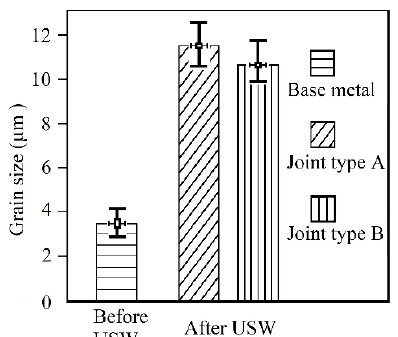
Figure 10. Comparison of base metal mean grain size before and after HP-USW for joint type A (1400 J) and joint type B (1100 J).